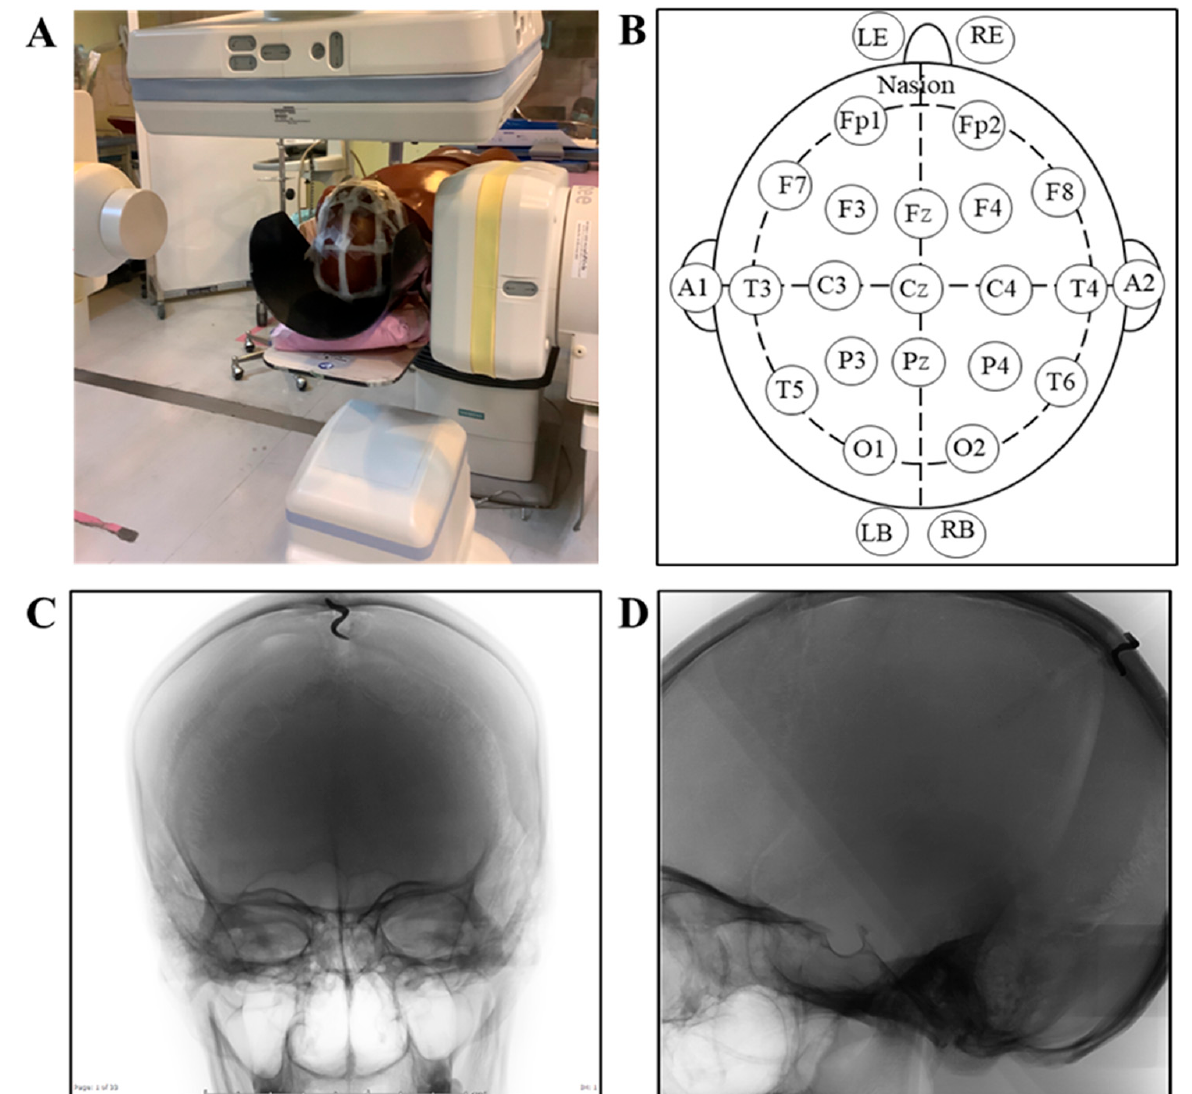
Figure 1. Phantom setting to evaluate radiation dose using nanoDot™ OSLDs: ( A ) phantom setting during the cerebral angiographic procedure; ( B ) the top view of the head demonstrates the location of the nanoDot™ OSLDs placed on the head phantom according to the 10/20 lead system (pre-frontal: Fp1, Fp2; frontal: F7, F3, Fz, F4, F8; temporal: T3, T5, T4, T6; parietal: P3, Pz, P4; occipital: O1, O2; center: C3, Cz, C4; and Auricle: A1, A2), on the eye lens (LE: left eye lens; RE: Right eye lens) and on the back of the neck on the left side (LB) and the right side (RB); ( C ) field of view of skull phantom from PA view; and ( D ) field of view of skull phantom from lateral